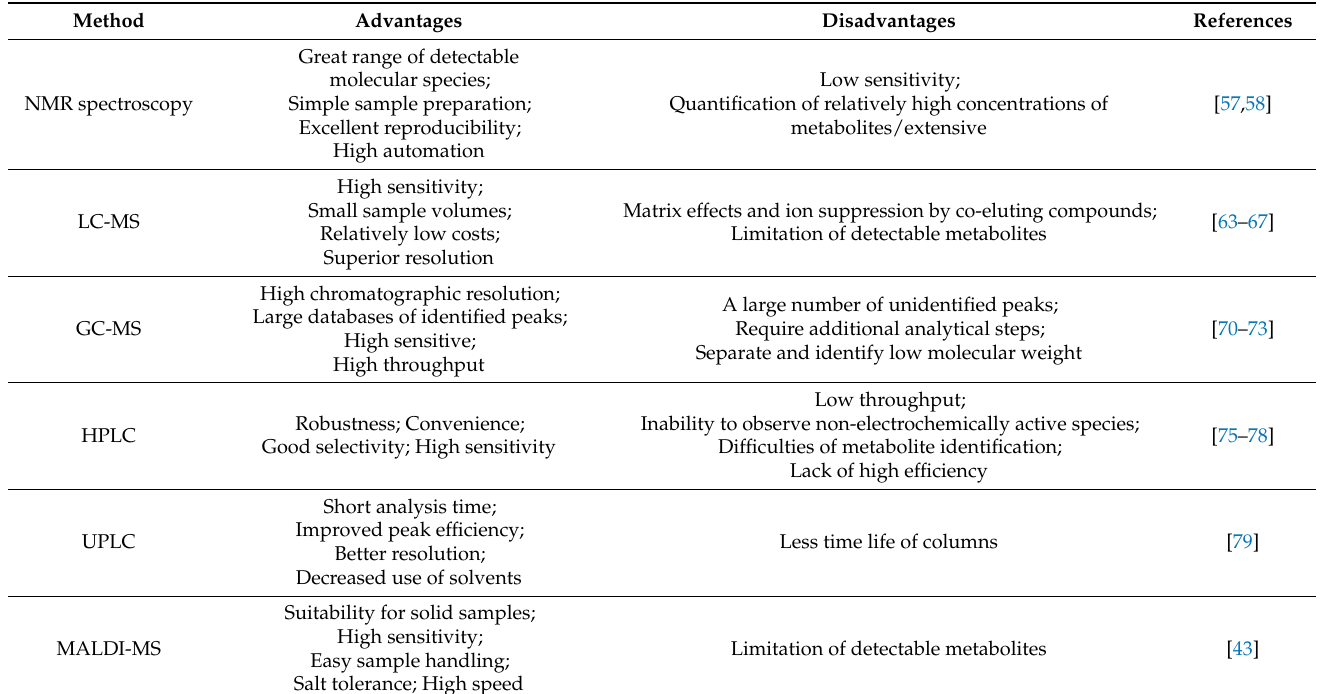
Table 1. Advantages and disadvantages of metabolomics